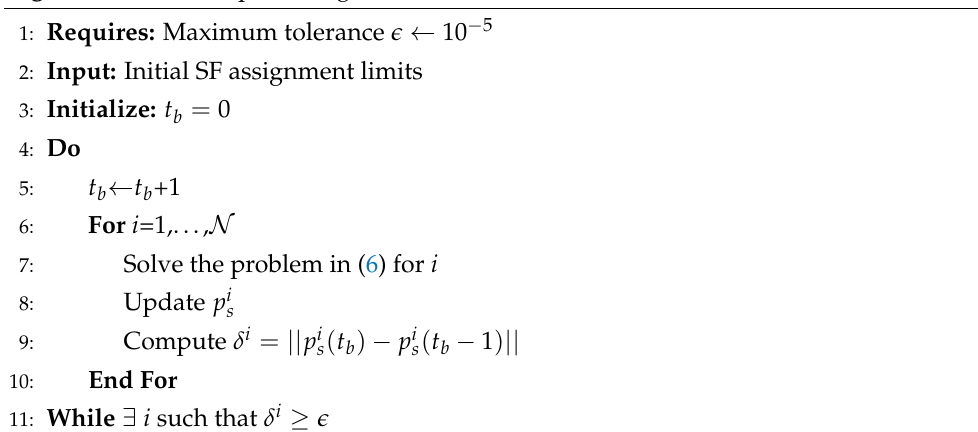
Algorithm 1 Best Response Algorithm for SF